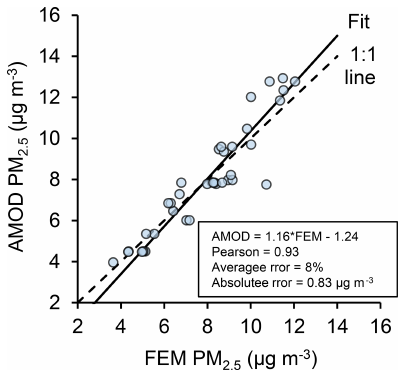
Figure 4. FEM PM 2 . 5 measurements vs. AMOD PM 2 . 5 measure- ments in micrograms per cubic meter ( n = 39). Each data point rep- resents a single 48h time-weighted average. All fit statistics were evaluated via Deming regression, assuming equal variance contri- butions from both measurement